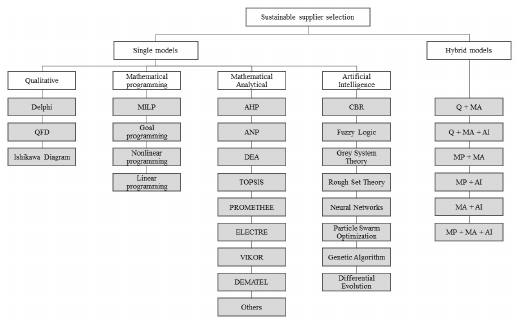
Figure 1. Classification of the sustainable supplier selection model in Zimmer et al.